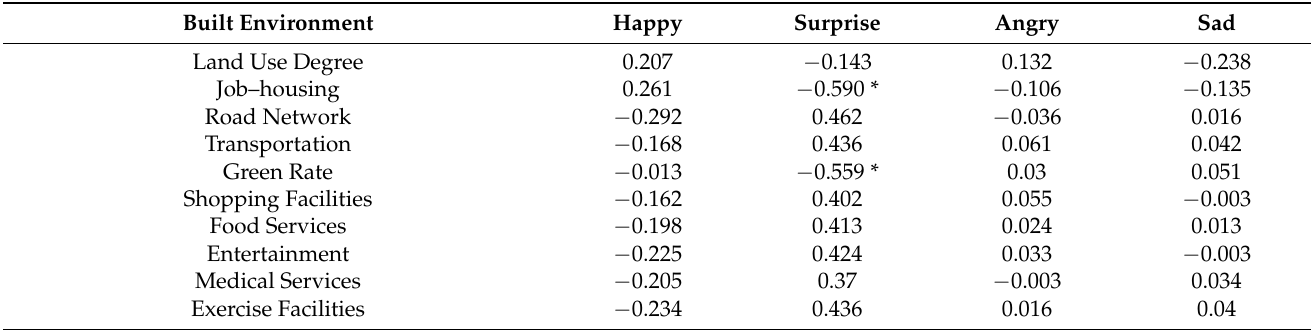
Table 7. Correlation between public sentiment intensity and built environment (scale: